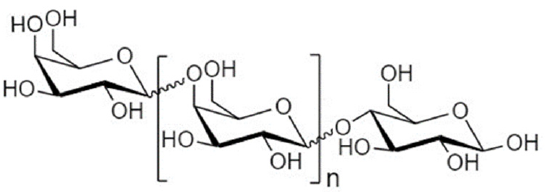
Figure 4. GOS structure: the main components of GOS are n 1,4- and 1,6-linked β -galactose monomers and a terminal β - D -galactose or β - D -glucose. GOS, galactooligosaccharides.